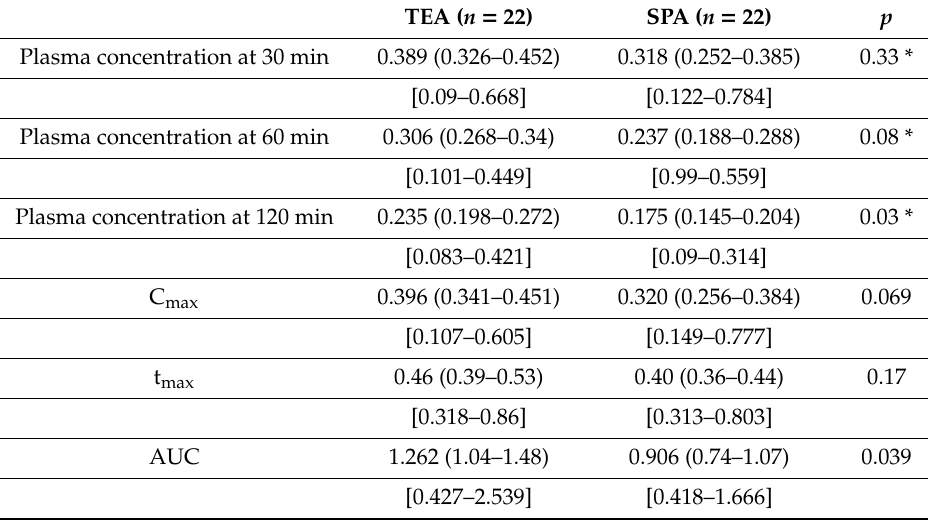
Table 3. Pharmacokinetic parameters.